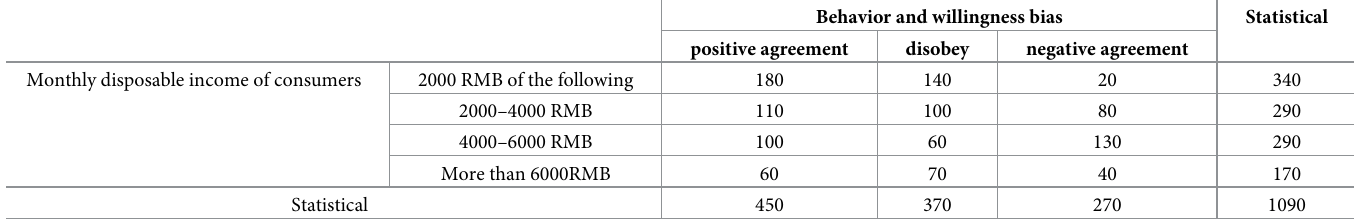
Table 7. Cross analysis of disposable income and dependent